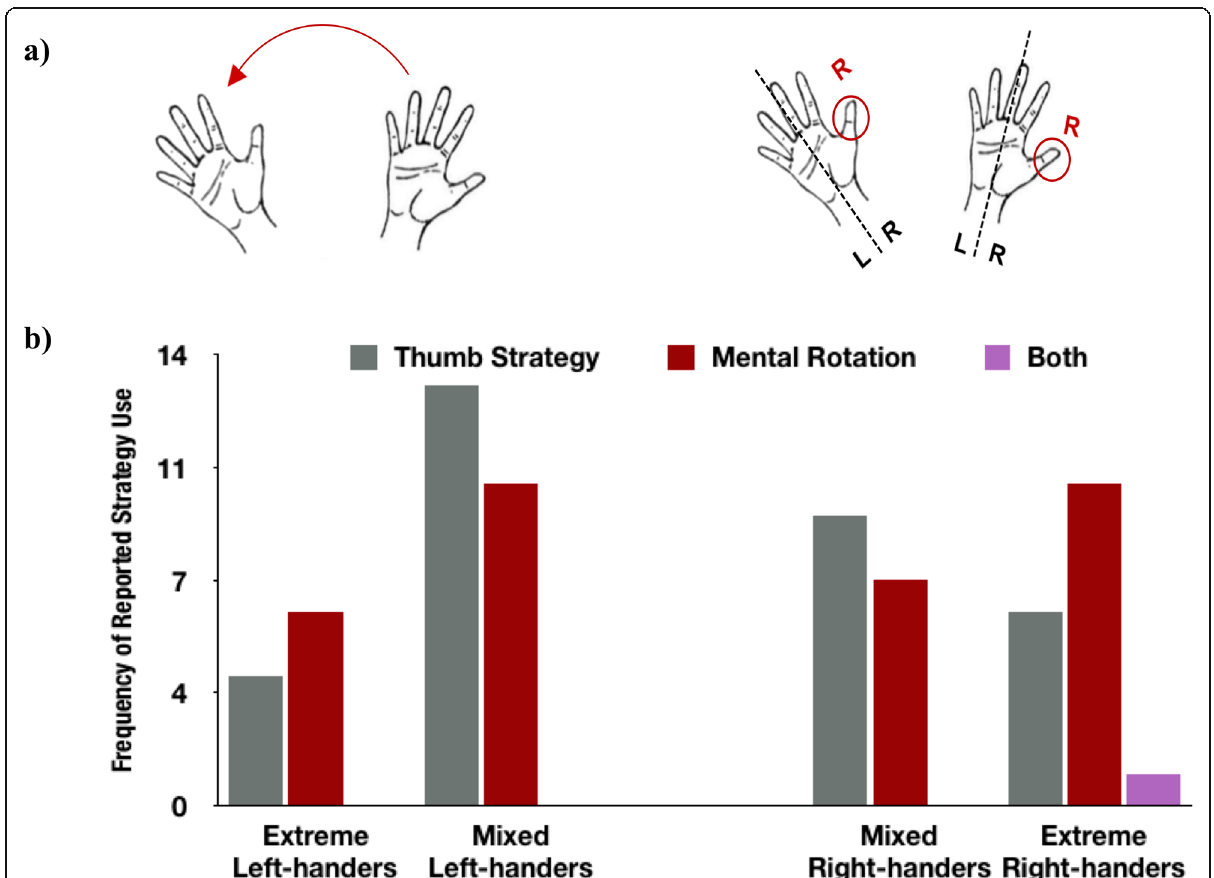
Fig. 6 Mental rotation strategy. a Strategies used in the mental rotation of hands. The mental rotation strategy is to mentally rotate one hand to align it with the other hand. The thumb strategy is to compare the relative position of the thumb on each hand. L to the left of the hand central axis line; R to the right of the hand central axis line. b Frequency of reported strategy use. We found no group differences or interactions in strategy